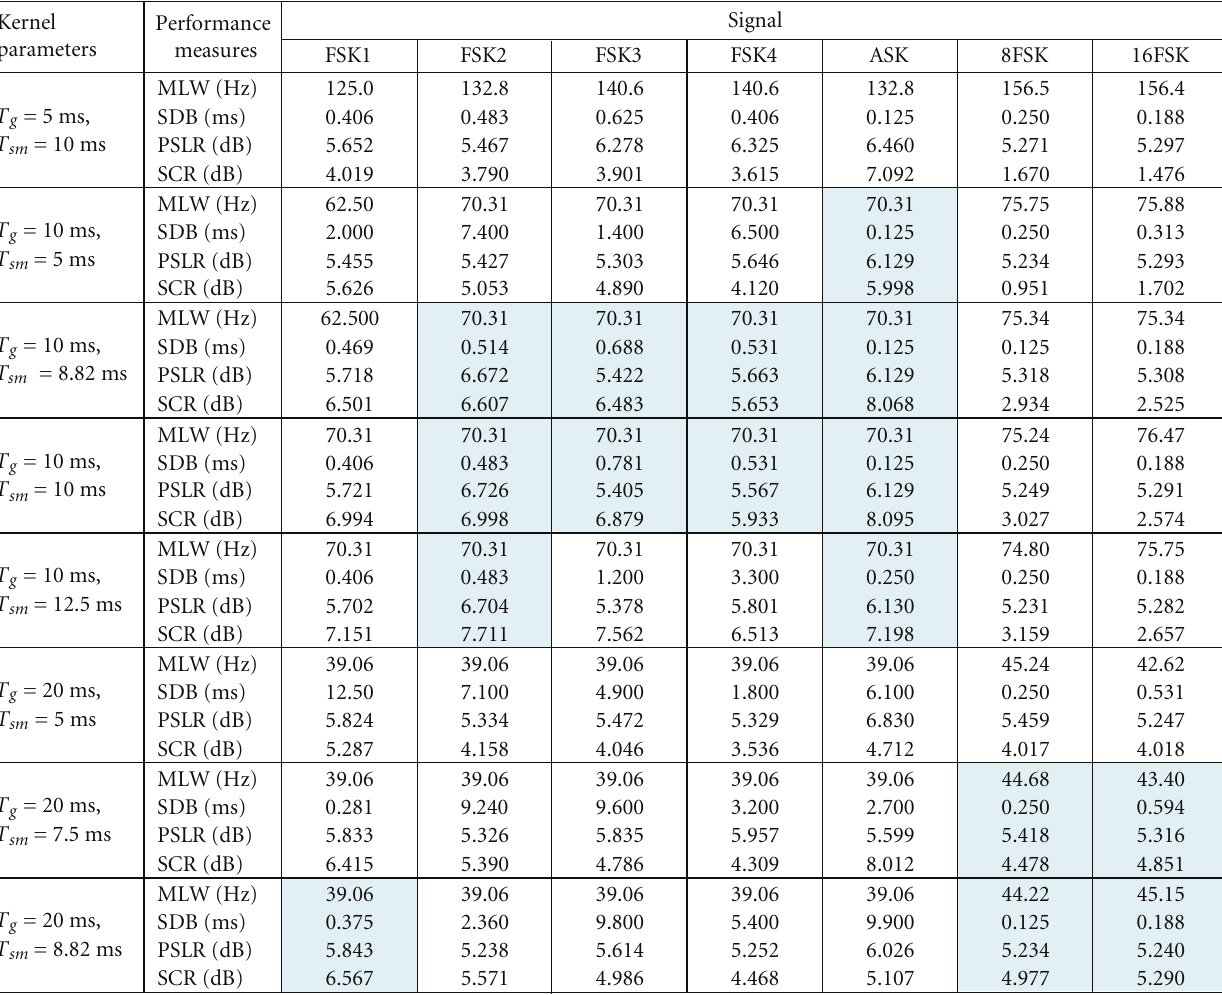
Table 2: Performance comparison for various kernel parameters. (Main-lobe width (MLW) and symbol-duration bias (SDB) should be low but peak-to-side lobe ratio (PSLR) and signal-to-cross terms ratio (SCR) should be high. Area highlighted in blue shows the set of kernel parameters that give optimal representation of the signals. It is shown that there are a few sets of kernel parameters that can give optimal representation for each